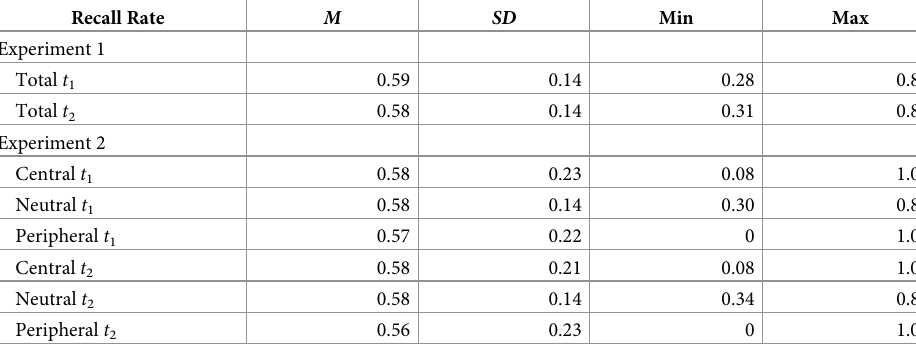
Table 4. Descriptive overview of all dependent variables for Experiments 1 and